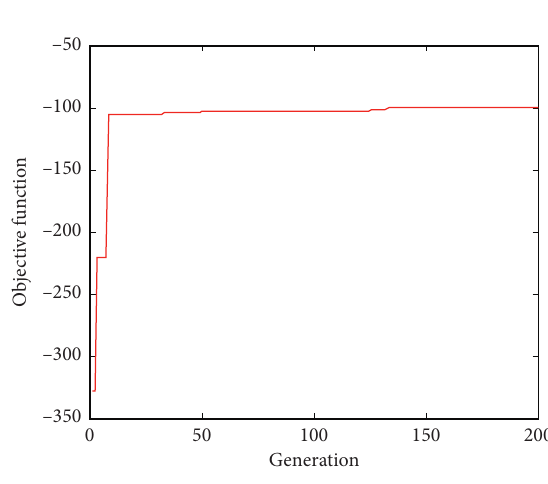
Figure 7: Iteration trace of SACG. Table 3: Same results for operation scheduling using different algorithms.